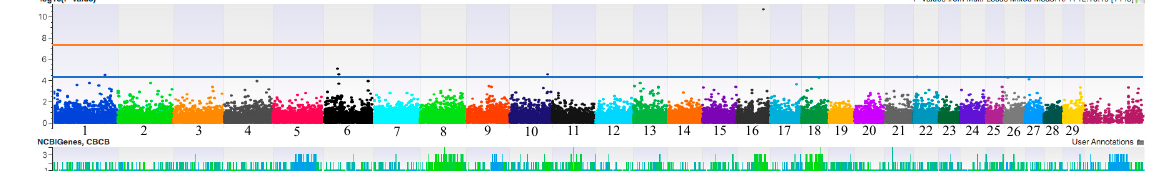
Figure 1. Manhattan plot for internal fat (KPH). Markers above − log10( p -value) of 5 × 10 − 8 (red line) are significant genome-wide association markers. Vertical clusters of markers are also of interest as they indicate potential quantitative trait loci (QTL) in those regions. Markers above − log10( p -value) of 5 × 10 − 5 (blue line) used to identify potential candidate genes for further research. Table 1. Markers identified to be significant in our genome-wide association analysis. Base Pair Proportion of Variation Trait 1 Chromosome Position Explained KPH Average 2 HCW Average 2 MARB Average 2 BF